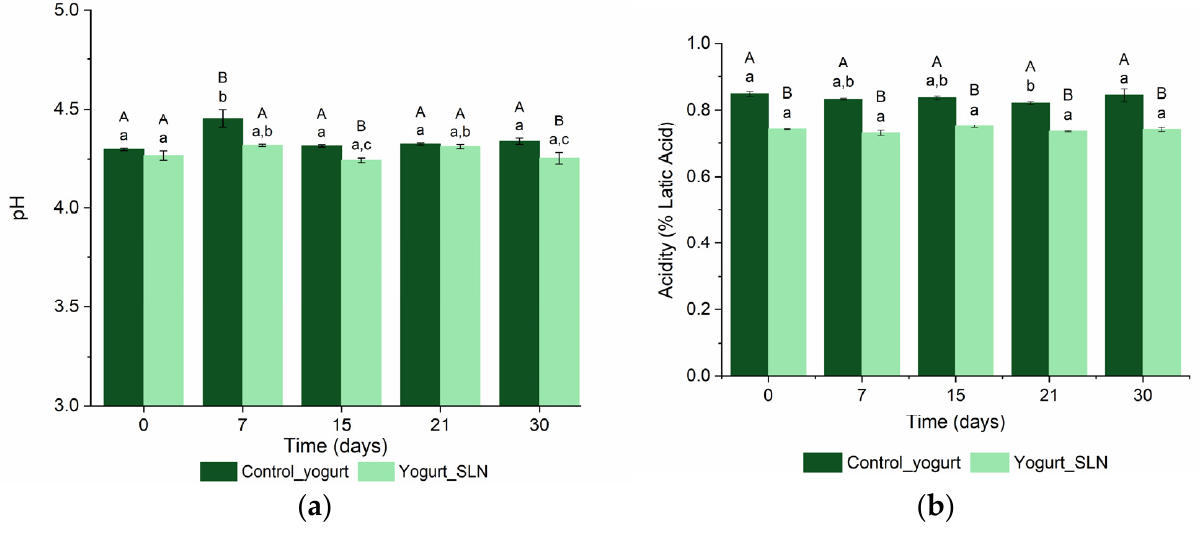
Figure 1. The pH ( a ) and titratable acidity ( b ) of control yogurt (i.e., plain yogurt) and yogurt with SLNs incorporated during the shelf-life. a–c Different lower-case letters indicate a statistically significant difference over time for the same sample ( p < 0.05). A–B Different uppercase letters indicate a statistically significant difference between samples for the same time ( p < 0.05).